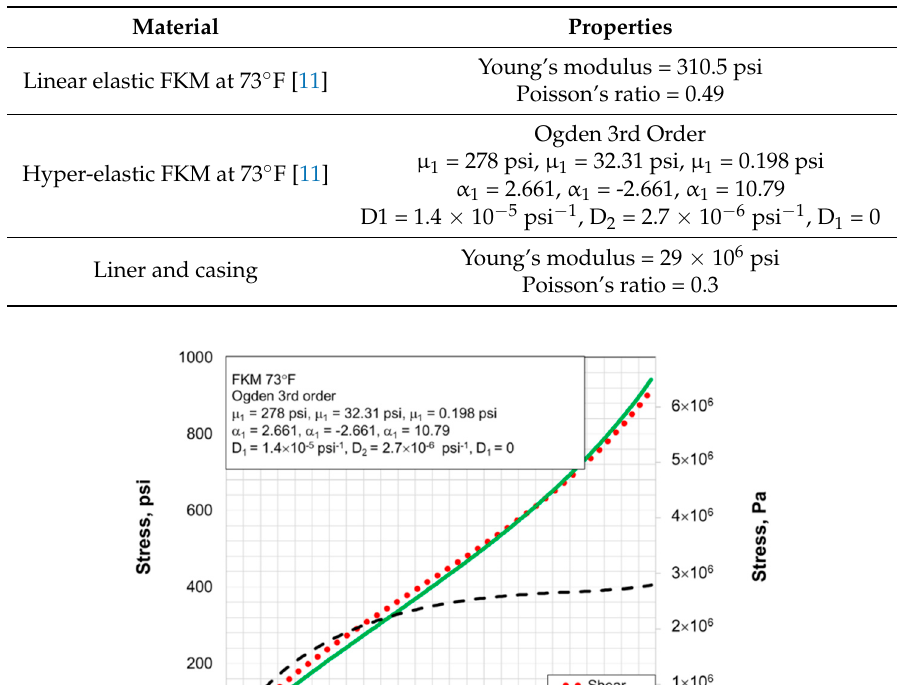
Table 1. Material properties used in the FEA model.